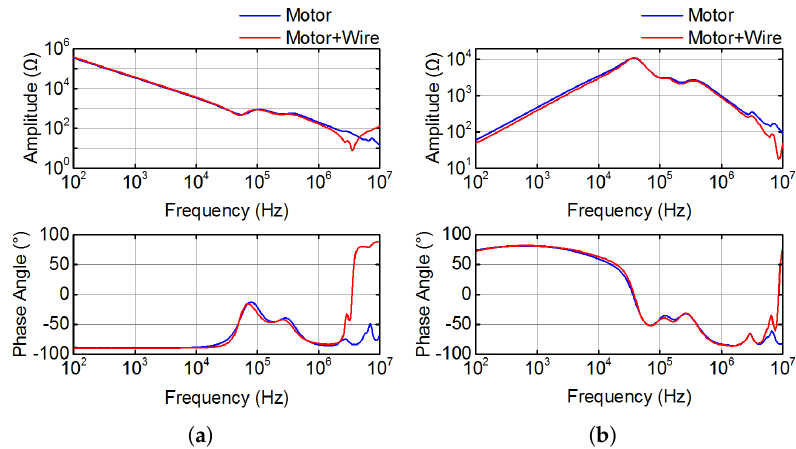
Figure 4. The CM and DM impedances of the motor: ( a ) CM impedance, ( b ) DM impedance.